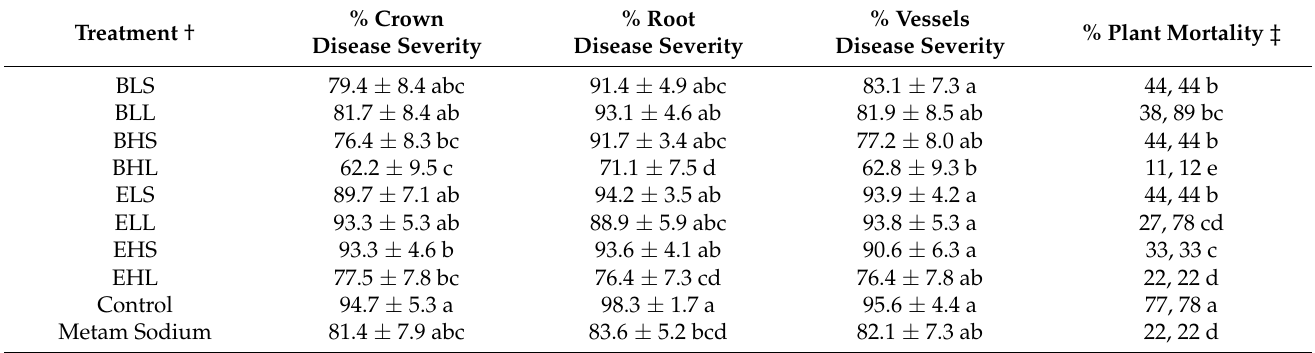
Table 5. Effects of treatments on the crown, root, vessel severity, and plant